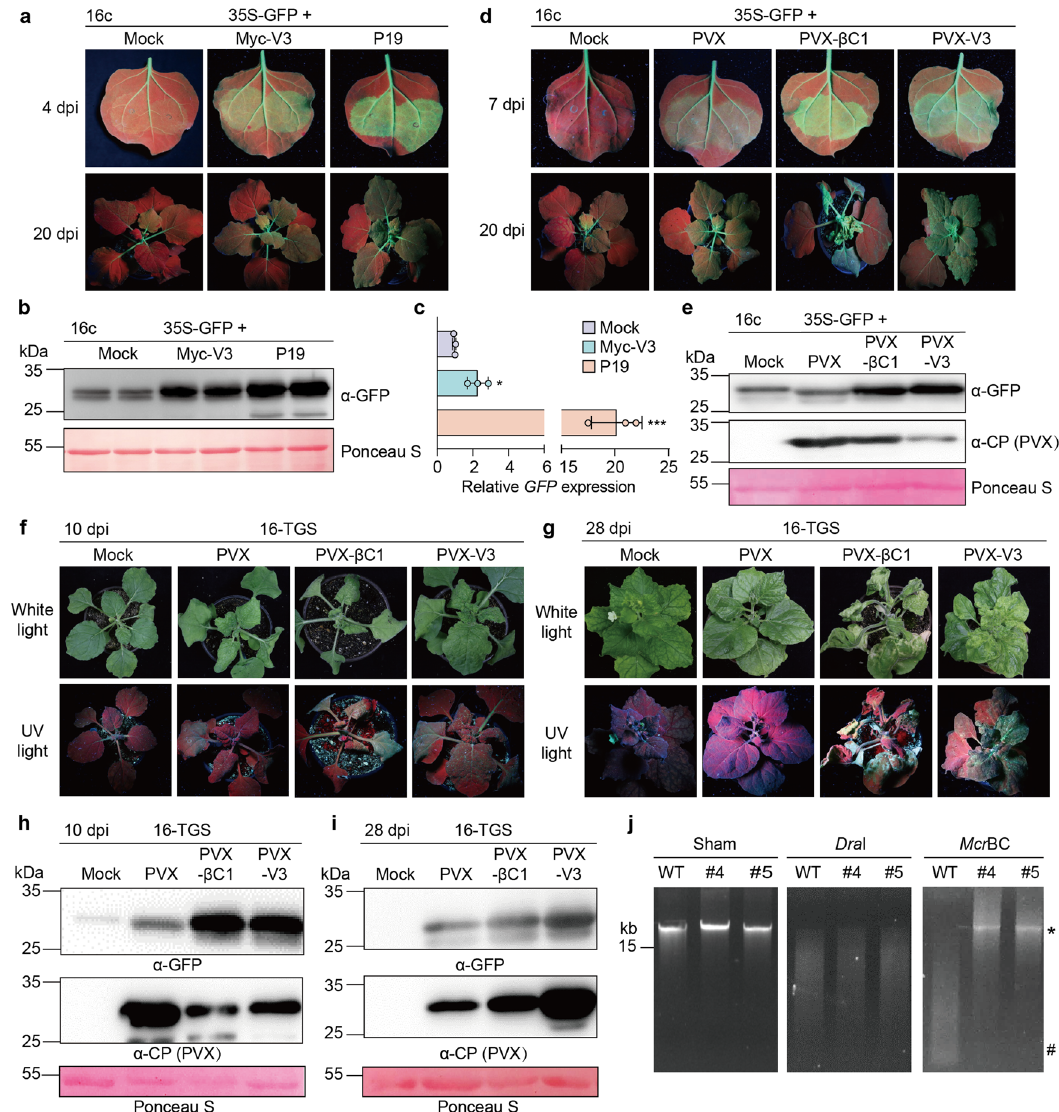
Fig. 5 V3 functions as a suppressor of PTGS and TGS. a Transgenic 16c N. benthamiana plants co-in fi ltrated with constructs to express GFP (35S-GFP) and Myc-V3, P19 (as positive control), or mock (empty vector, as negative control) at 4 dpi (upper panel) or 20 dpi (lower panel) under UV light. b Western blot showing the GFP accumulation in inoculated leaves from ( a ) at 4 dpi. The corresponding Ponceau S staining of the large RuBisCO subunit serves as a loading control. This experiment was repeated three times with similar results; representative images are shown. c Relative GFP mRNA accumulation in inoculated leaves from ( a ) at 4 dpi measured by qRT-PCR. Data are the mean of three independent biological replicates. Error bars represent SD. An asterisk indicates a statistically signi fi cant difference according to unpaired Student ’ s t test (two-tailed), * p < 0.5, *** p < 0.001. NbActin2 was used as the internal reference. d Transgenic 16c N. benthamiana plants co-in fi ltrated with constructs to express GFP (35S-GFP) and PVX, PVX-V3, PVX- β C1 (as positive control), or mock (in fi ltration buffer, as negative control) at 7 dpi (upper panel) or 20 dpi (lower panel) under UV light. e Western blot showing the GFP accumulation in inoculated leaves from ( d ) at 7 dpi. The corresponding Ponceau S staining of the large RuBisCO subunit serves as loading control. This experiment was repeated three times with similar results; representative images are shown. f , g Symptoms of 16-TGS N . benthamiana plants infected with PVX, PVX-V3, PVX- β C1 (as positive control), or mock-inoculated under white light or UV light at 10 dpi ( f ) and 28 dpi ( g ). h , i Western blot showing accumulation of GFP and PVX CP in systemically infected leaves from ( f ) and ( i ). The corresponding Ponceau S staining of the large RuBisCO subunit serves as loading control. This experiment was repeated three times with similar results; representative images are shown. j DNA methylation analysis by restriction enzyme digestion in V3-YFP transgenic N. benthamiana plants. Genomic DNA extracted from WT N. benthamiana or two independent V3-YFP transgenic lines (#4 and #5) was digested with the methylation-dependent restriction enzyme Mcr BC and the methylation-insensitive enzyme Dra I. “ Sham ” indicates a mock digestion with no enzyme added. The positions of undigested input genomic DNA is indicated with an asterisk; the position of the Mcr BC-digested products is indicated with a hashtag. This experiment was repeated three times with similar results; representative images are shown. The original data from all experiments and replicates can be found in the Source data fi